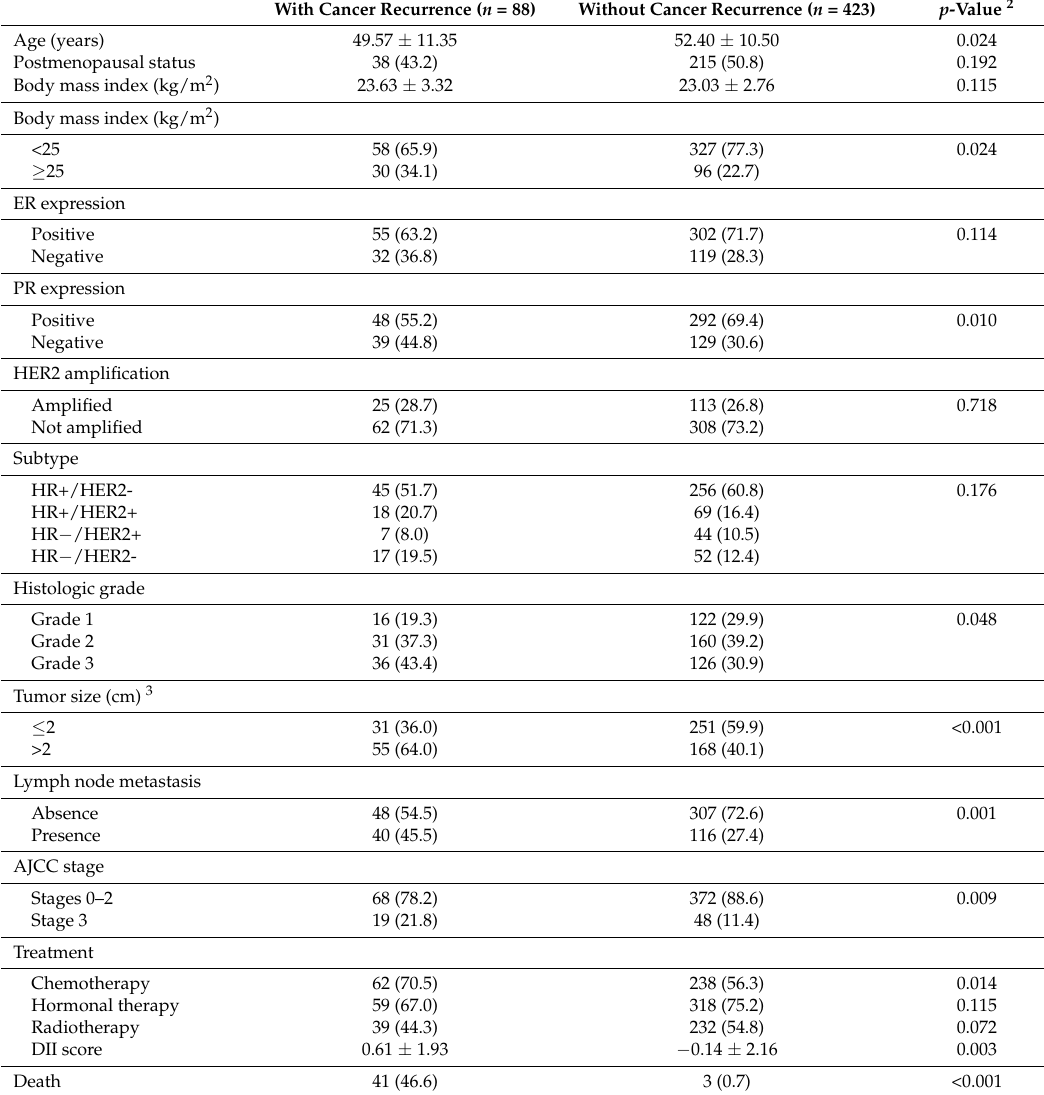
Table 1. Baseline characteristics of patients with and without breast cancer recurrence 1